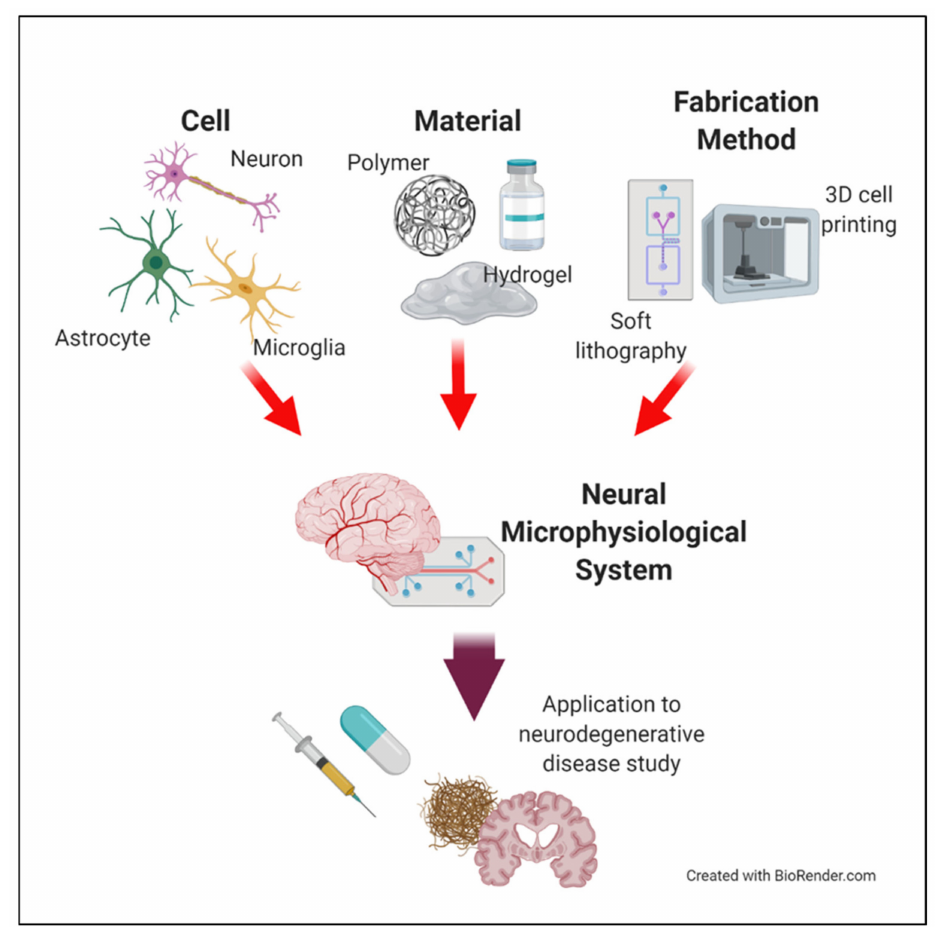
Figure 1. Schematic of the essential components for creating neural microphysiological system